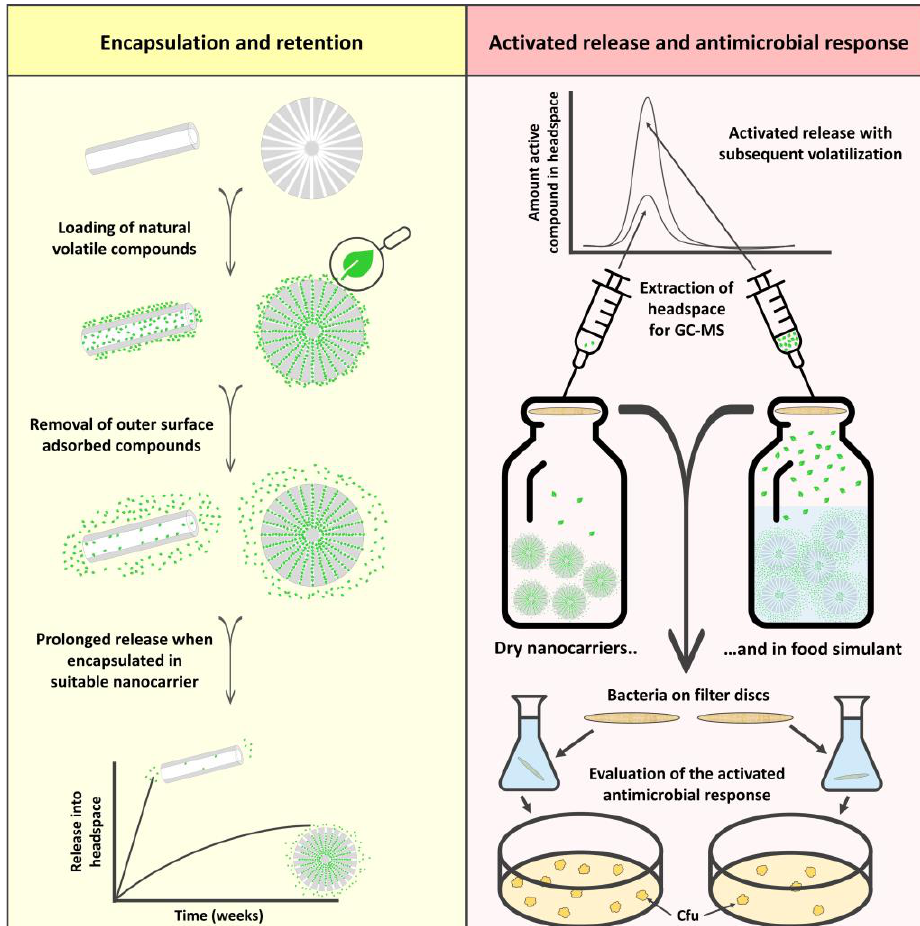
Figure 1. Schematic illustration of the study. The left (yellow) column represents the encapsulation of different volatile essential oil compounds into porous silica nanocarriers and halloysite nanotubes. A suitable nanocarrier gives rise to a sustained release profile which levels out after several weeks. The right (red) column demonstrates the activated release from the nanocarriers, and the resultant higher amount of active compounds in the headspace. The antimicrobial effect of the active compounds vaporized into headspace is investigated in closed containers, as schematically described in the figure.